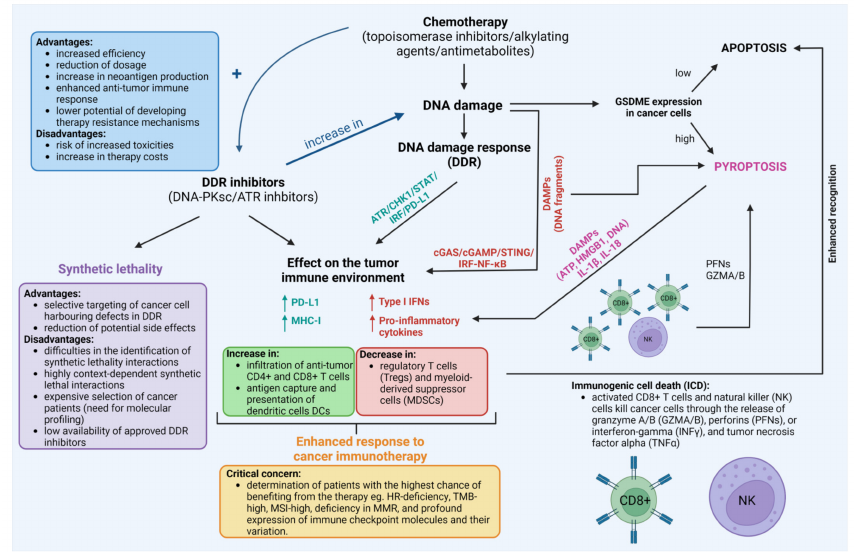
Figure 5. The existing links between the use of chemotherapeutic drugs, DNA damage response (DDR) inhibitors, and immunotherapy with the crucial questions, advantages, and disadvantages of their use. For reference see Section 7. Created with BioRender.com accessed on 1 February